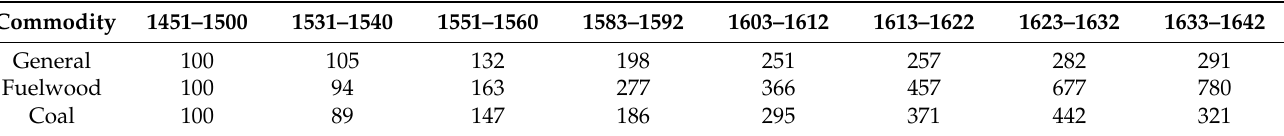
Table 1. Indices of estimated price movements in London,